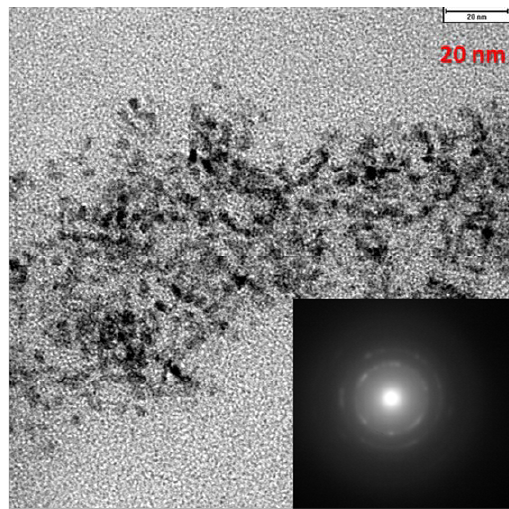
Fig. 3. TEM image of germanium colloidal